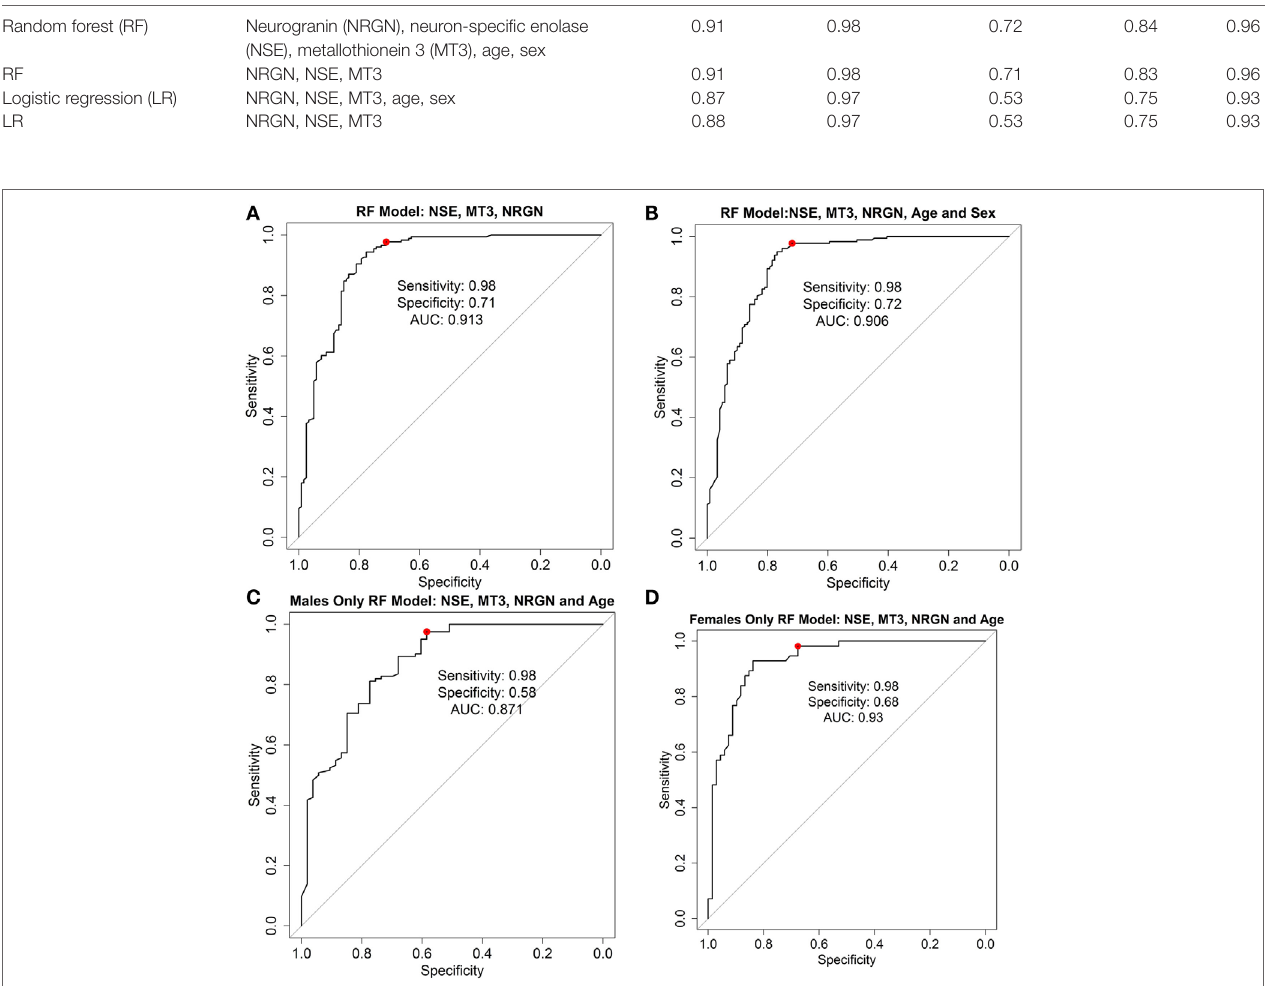
FigUre 5 | Receiver operator characteristic curves for random forest (RF) models. ROC curve analysis showing plotted models built using three biomarkers neurogranin (NRGN), metallothionein 3 (MT3), and neuron-specific enolase (NSE) only (a) , three biomarkers with age and sex as covariates in the model (B) , biomarkers and age in the male patients only (c) , and biomarkers and age in female patients only (D) . The red dot indicates the threshold point for the reported optimal sensitivity (0.98) and the corresponding specificity for classifying mild TBI versus healthy controls. Area under the curve (AUC = C-statistic; CI, confidence intervals for each AUC estimate) is indicated for each